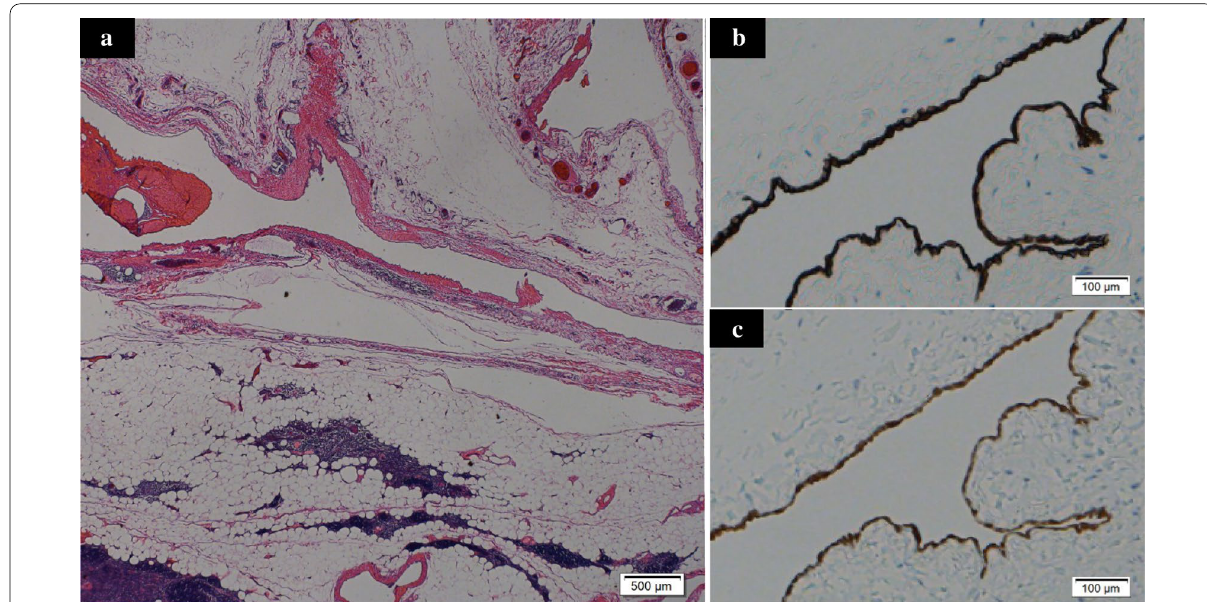
Fig. 5 Microscopically, the cyst wall was lined by cubic cells underlaid by loose connective tissue. The remnants of the thymus were not adjacent to the cyst wall ( a ). Immunohistologically, the cyst consisted of a thin wall with a single layer of mesothelial cells positive for cytokeratin 7 ( b ) and calretinin ( c